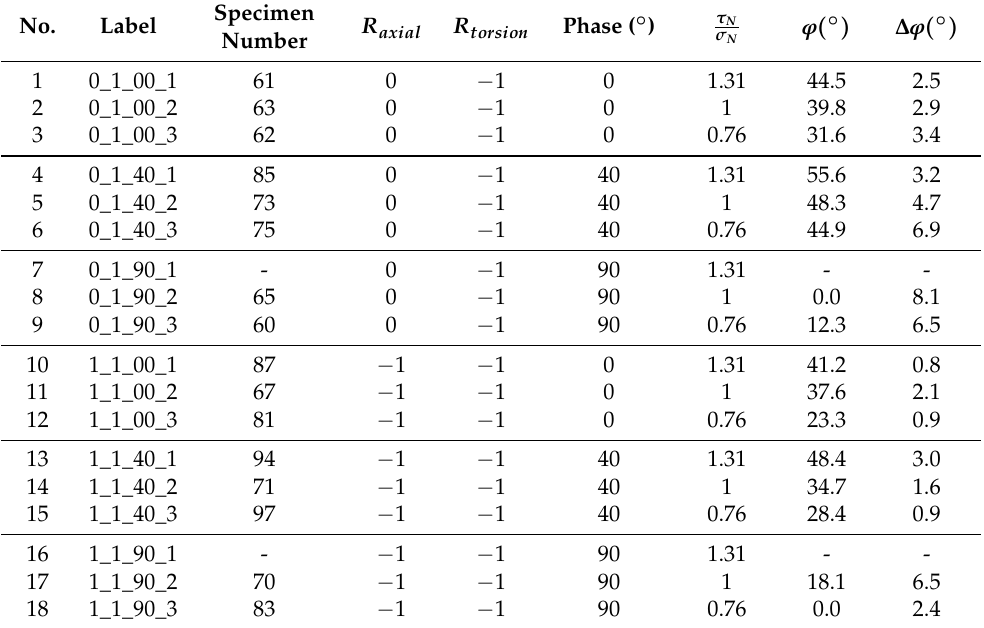
Table 5. Experimental deflection angle and numerical deviation